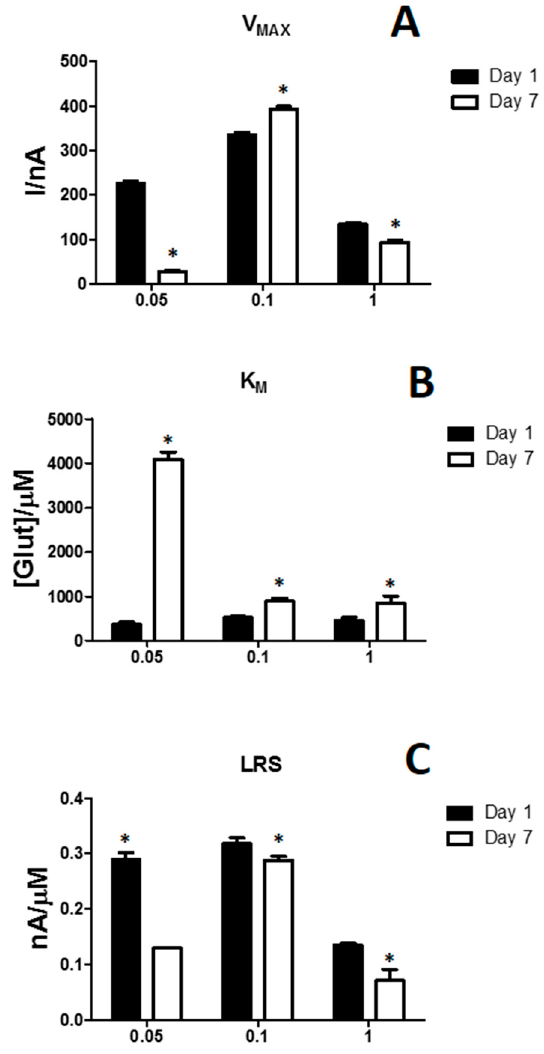
Figure 4. Bar chart displaying the modifications of V MAX (Panel A), K M (Panel B) and LRS (Panel C) on biosensor designs loading different PG concentrations (0.05%, 0.1% and 1%) at Day 1 (black bars) and Day 7 (withe bars). Values are expressed as mean ± SEM. *p < 0.05 vs. Day 1.